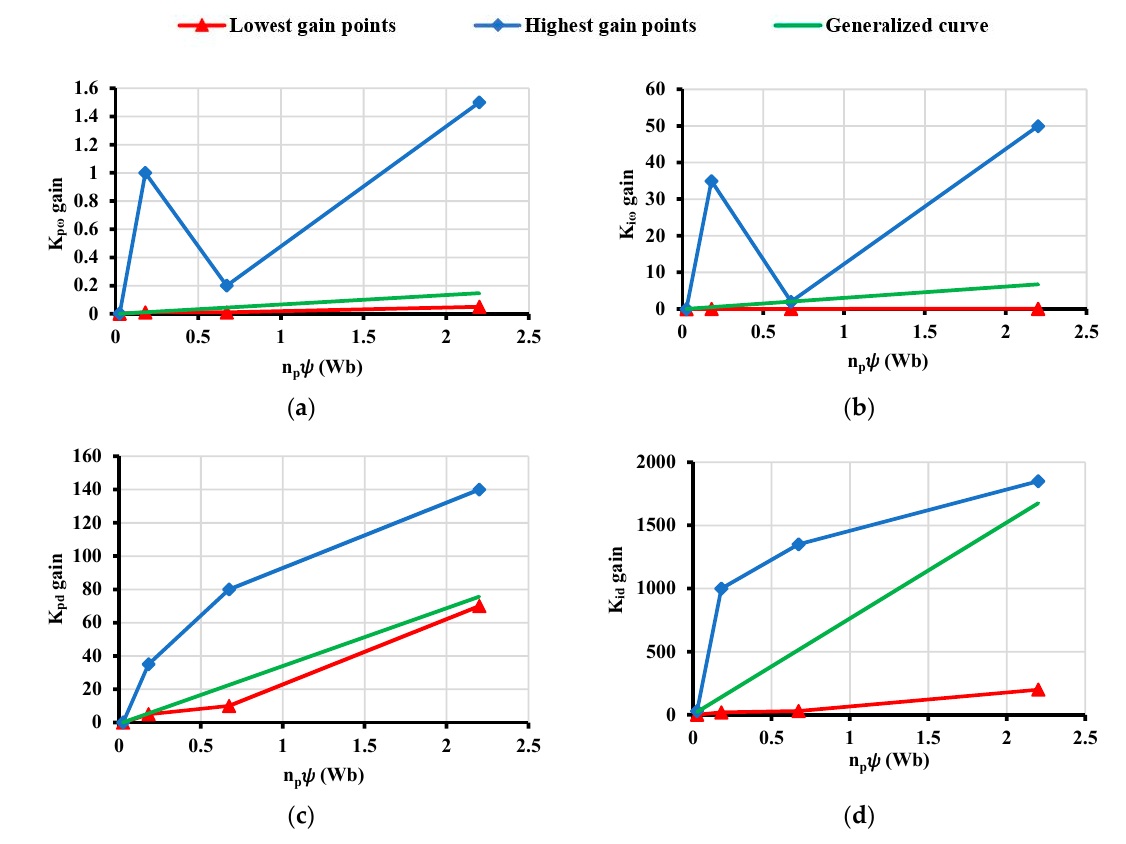
Figure 8. Plots of PI control gains versus n p ψ product values. ( a ) K p ω ; ( b ) K i ω ; ( c ) K pd ; ( d ) K id .